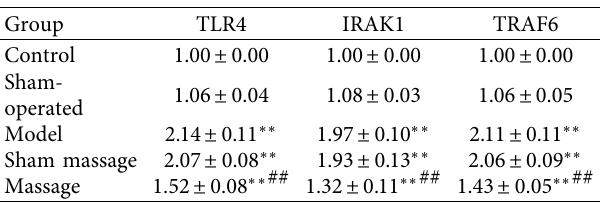
Table 4: TLR4, IRAK1, and TRAF6 mRNA expression. The data are shown as X ± s ; n � 8. ∗∗ P < 0 . 0 compared with the control group;## P < 0 . 01 compared with the model group. Group